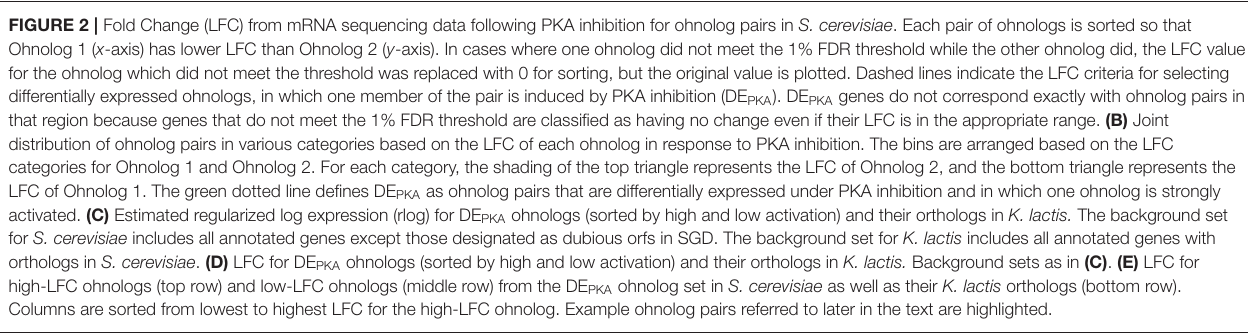
FIGURE 2 | Fold Change (LFC) from mRNA sequencing data following PKA inhibition for ohnolog pairs in S. cerevisiae . Each pair of ohnologs is sorted so that Ohnolog 1 ( x -axis) has lower LFC than Ohnolog 2 ( y -axis). In cases where one ohnolog did not meet the 1% FDR threshold while the other ohnolog did, the LFC value for the ohnolog which did not meet the threshold was replaced with 0 for sorting, but the original value is plotted. Dashed lines indicate the LFC criteria for selecting differentially expressed ohnologs, in which one member of the pair is induced by PKA inhibition (DE PKA ). DE PKA genes do not correspond exactly with ohnolog pairs in that region because genes that do not meet the 1% FDR threshold are classified as having no change even if their LFC is in the appropriate range. (B) Joint distribution of ohnolog pairs in various categories based on the LFC of each ohnolog in response to PKA inhibition. The bins are arranged based on the LFC categories for Ohnolog 1 and Ohnolog 2. For each category, the shading of the top triangle represents the LFC of Ohnolog 2, and the bottom triangle represents the LFC of Ohnolog 1. The green dotted line defines DE PKA as ohnolog pairs that are differentially expressed under PKA inhibition and in which one ohnolog is strongly activated. (C) Estimated regularized log expression (rlog) for DE PKA ohnologs (sorted by high and low activation) and their orthologs in K. lactis. The background set for S. cerevisiae includes all annotated genes except those designated as dubious orfs in SGD. The background set for K. lactis includes all annotated genes with orthologs in S. cerevisiae . (D) LFC for DE PKA ohnologs (sorted by high and low activation) and their orthologs in K. lactis. Background sets as in (C) . (E) LFC for high-LFC ohnologs (top row) and low-LFC ohnologs (middle row) from the DE PKA ohnolog set in S. cerevisiae as well as their K. lactis orthologs (bottom row). Columns are sorted from lowest to highest LFC for the high-LFC ohnolog. Example ohnolog pairs referred to later in the text are highlighted. expression didn’t change ( p = 9.2e-5) ( Figure 1C right